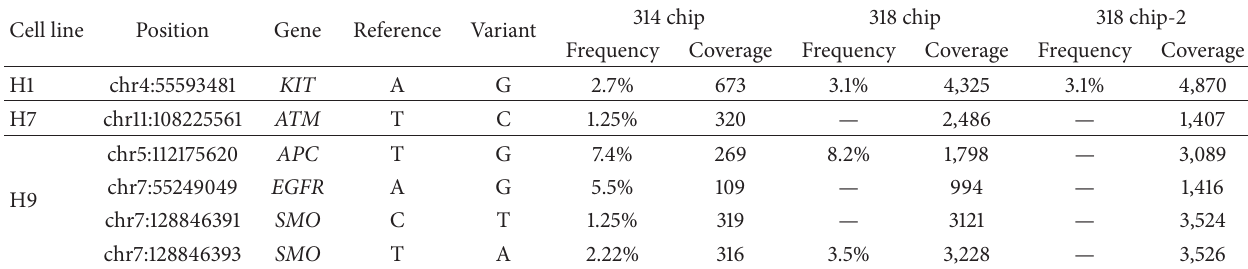
Table 3: Rare variants identified in the four human embryonic stem cell lines after exposure to 1Gy of ionizing radiation. Cell